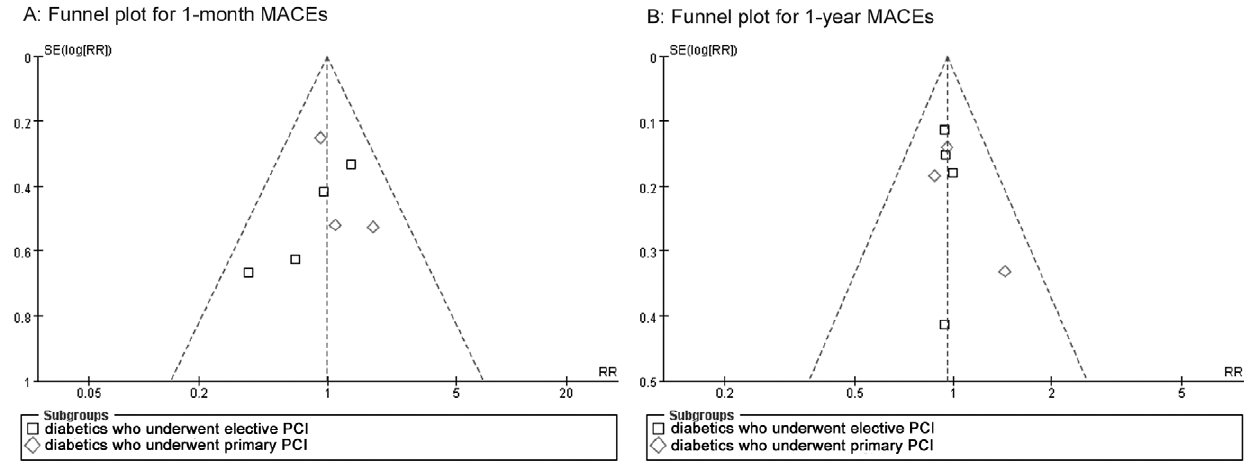
Figure 5. Publication bias analysis by funnel plots. Funnel plots for (A) 1-month MACEs for elective and primary PCI; (B) 1-year MACEs for elective and primary PCI.